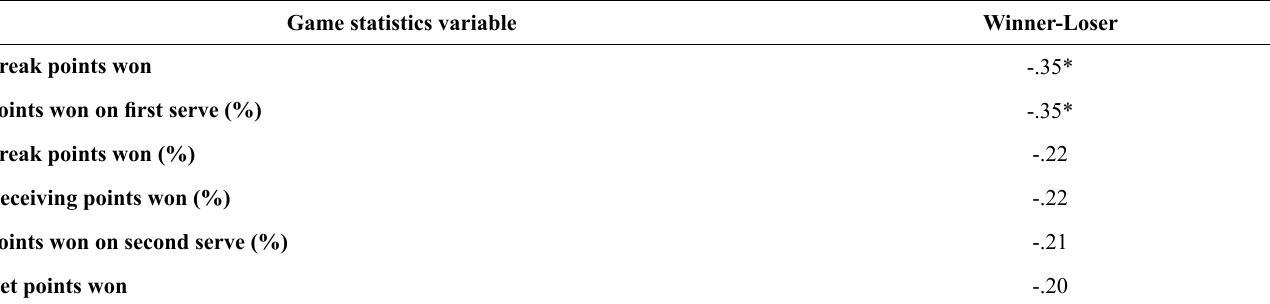
Table 3. Standardized coefficients from the discriminant analysis of the game statistics between winning and losing wheelchair tennis players in the 2012 Paralympics